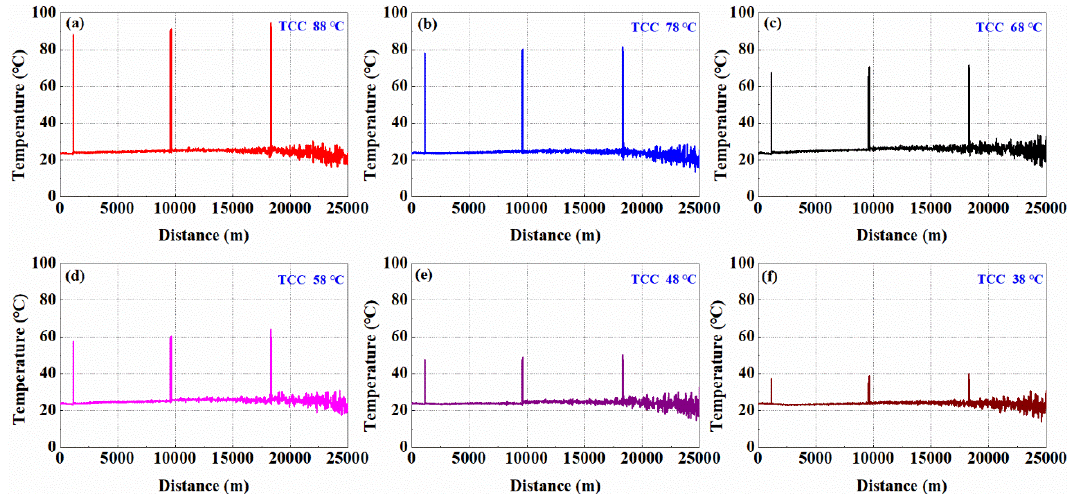
Figure 5. The results of temperature-distance traces along the sensing fiber of 25 km from 38 °C to 88 °C in Fiber Under Test (FUT). (a) Temperature-distance traces for FUT at 88 °C; (b) Temperature-distance traces for FUT at 78 °C; (c) Temperature-distance traces for FUT at 68 °C; (d) Temperature-distance traces for FUT at 58 °C; (e) Temperature-distance traces for FUT at 48 °C; (f) Temperature-distance traces for FUT at 38 °C.